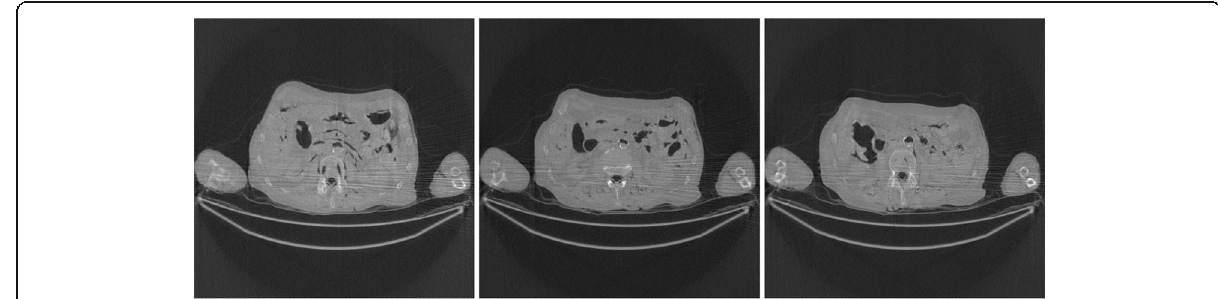
Fig. 10 FBP reconstruction of three image slices using the low-dose data without pre-filtering. Left to Right: Slice 1, Slice 32, and Slice 64